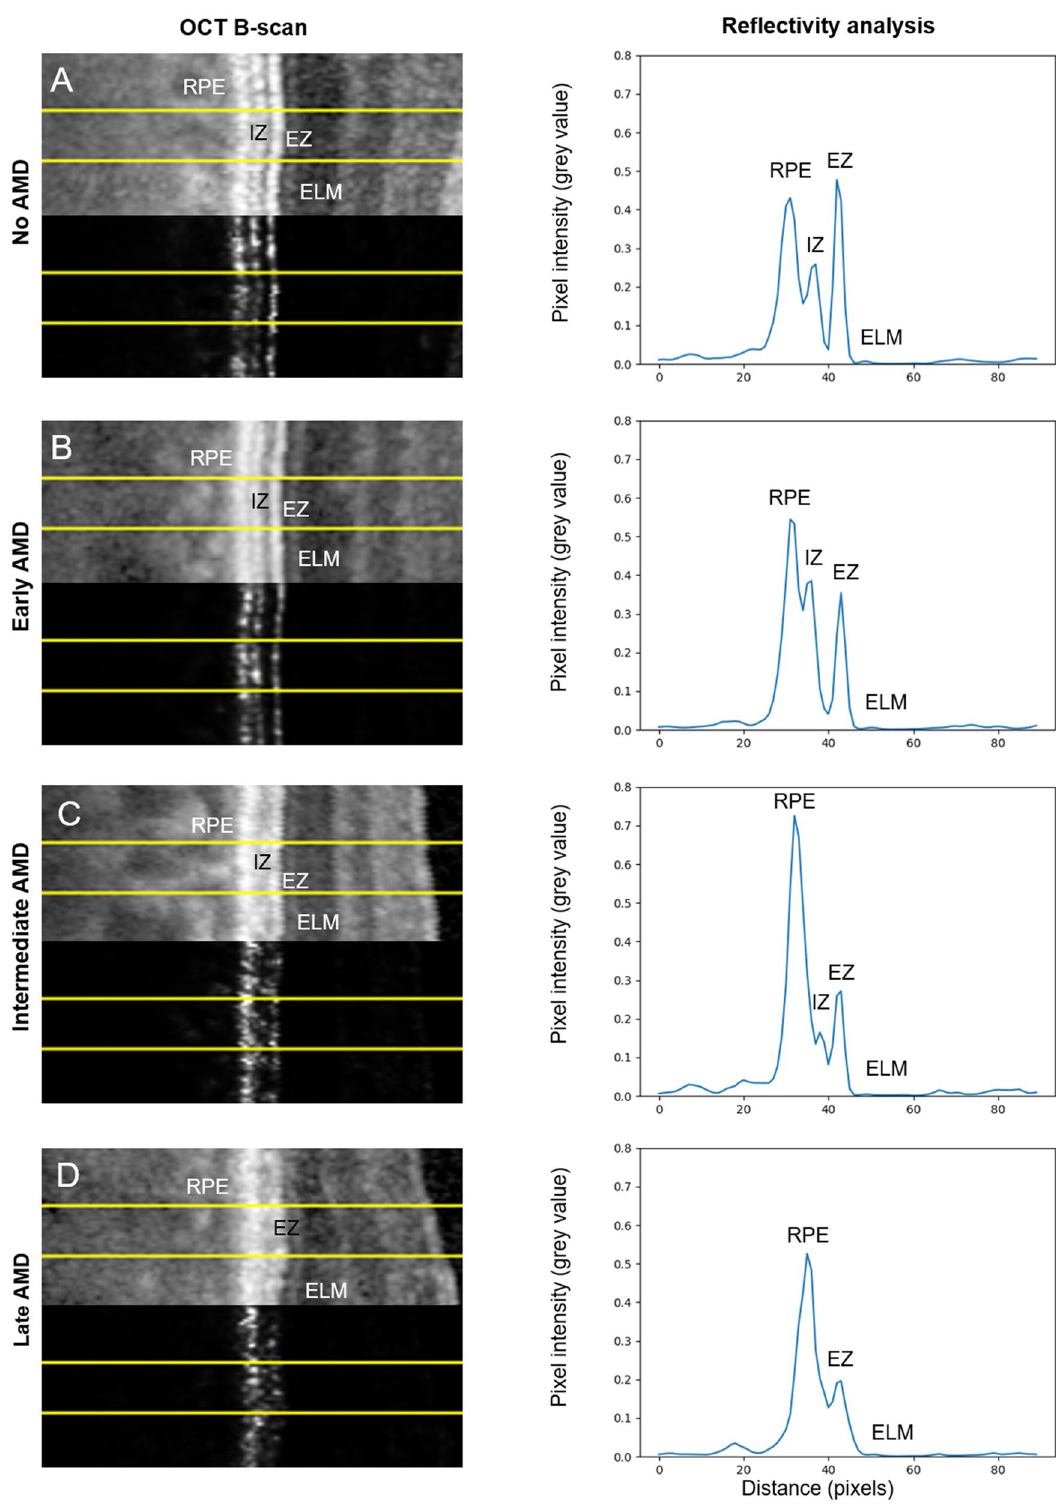
Figure 2. SD-OCT image details (pixel intensities displayed: logarithmic transformed (above) and raw (below)) of representative cases for ( A ) healthy controls, ( B ) early AMD, ( C ) intermediate AMD and ( D ) late AMD and their corresponding reflectivity profiles. The yellow superimposed yellow lines indicate the region of interest (ROI) on the logarithmic (above) and the linear (below) displayed OCT scan. Note, while the logarithmic displayed OCT image is presented for better visualization of outer retinal structure, all actual rEZR analyses in this study were performed in the image raw data (linear